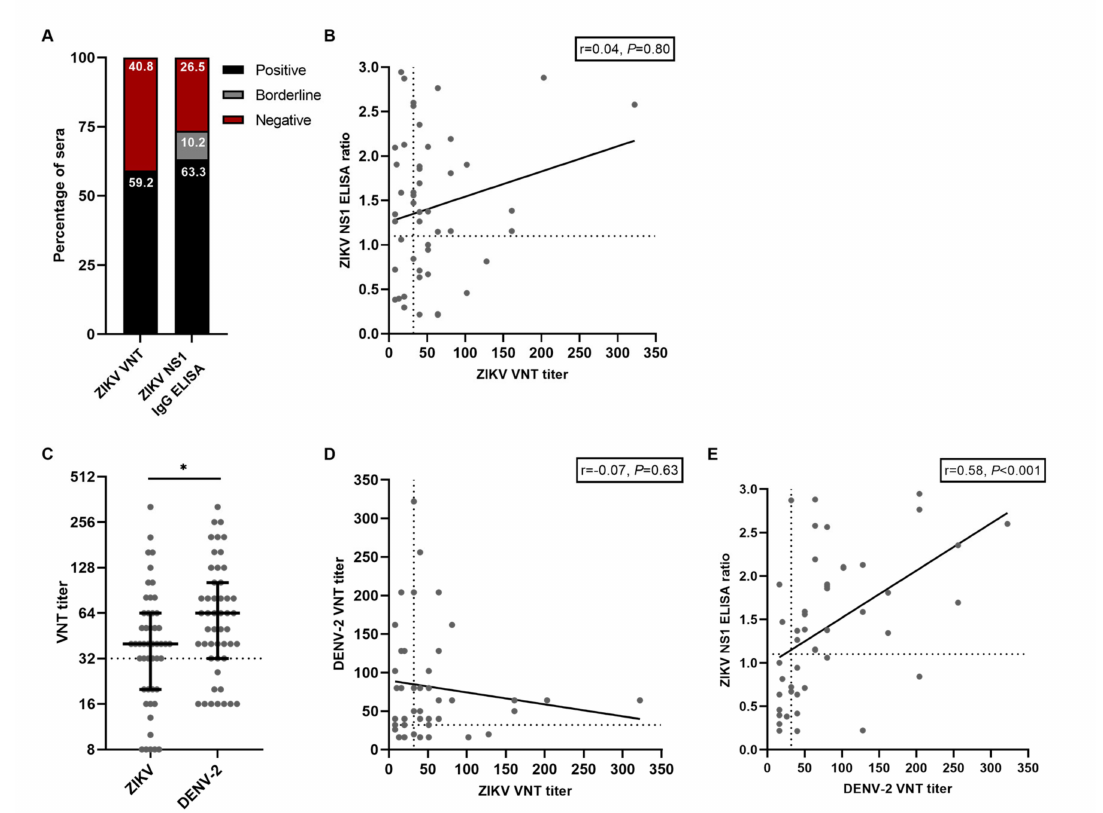
Figure 1. Results from serological assays for ZIKV and DENV antibodies . A : Percentage of positive and negative tested sera with ZIKV VNT and ZIKV NS1 IgG ELISA. B : Correlation between ZIKV NS1 IgG ELISA ratios and titers from the ZIKV VNT. The dotted lines indicate cut-off values for a positive test result. C : ZIKV- and DENV-2 VNT titers from all participants. Lines represent median ± IQR. The dotted line indicates the cut-off value for a positive test result. Statistical differences were tested with the Mann–Whitney test. D : Correlation between DENV-2 VNT titers and ZIKV VNT titers. The dotted lines indicate cut-off values for a positive test result. E : Correlation between ZIKV NS1 IgG ELISA ratios and DENV-2 VNT titers. The dotted lines indicate cut-off values for a positive test result. * P <